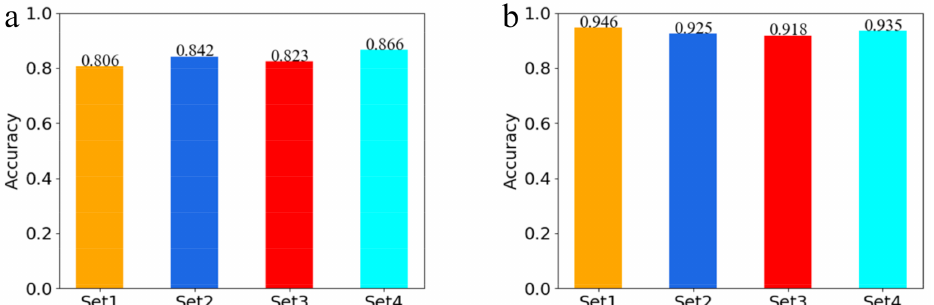
Figure 3. The recognition accuracy of flow patterns by SVM algorithm, ( a ) Experiment 1: gas-liquid